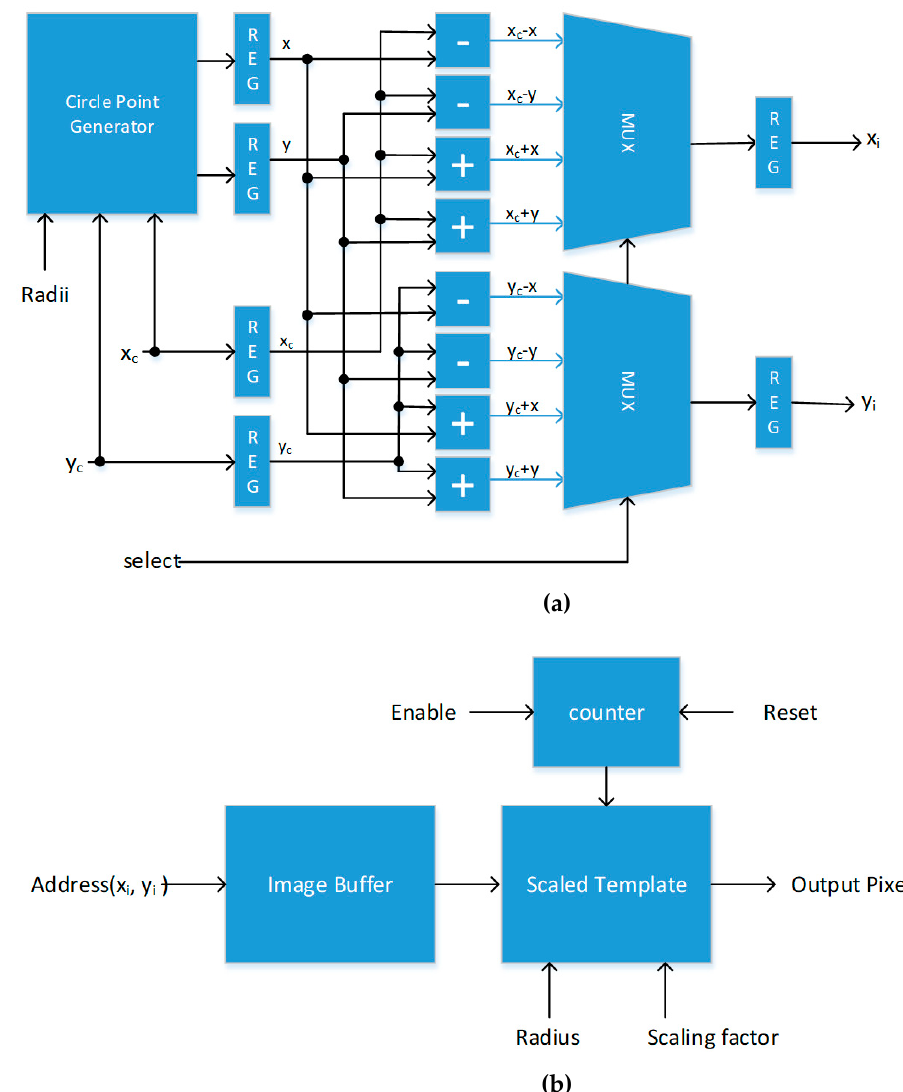
Figure 7. Pipeline architecture design for the unwrapping process: ( a ) Pixel location generator based on BCA and ( b ) template generator with a scaling factor.